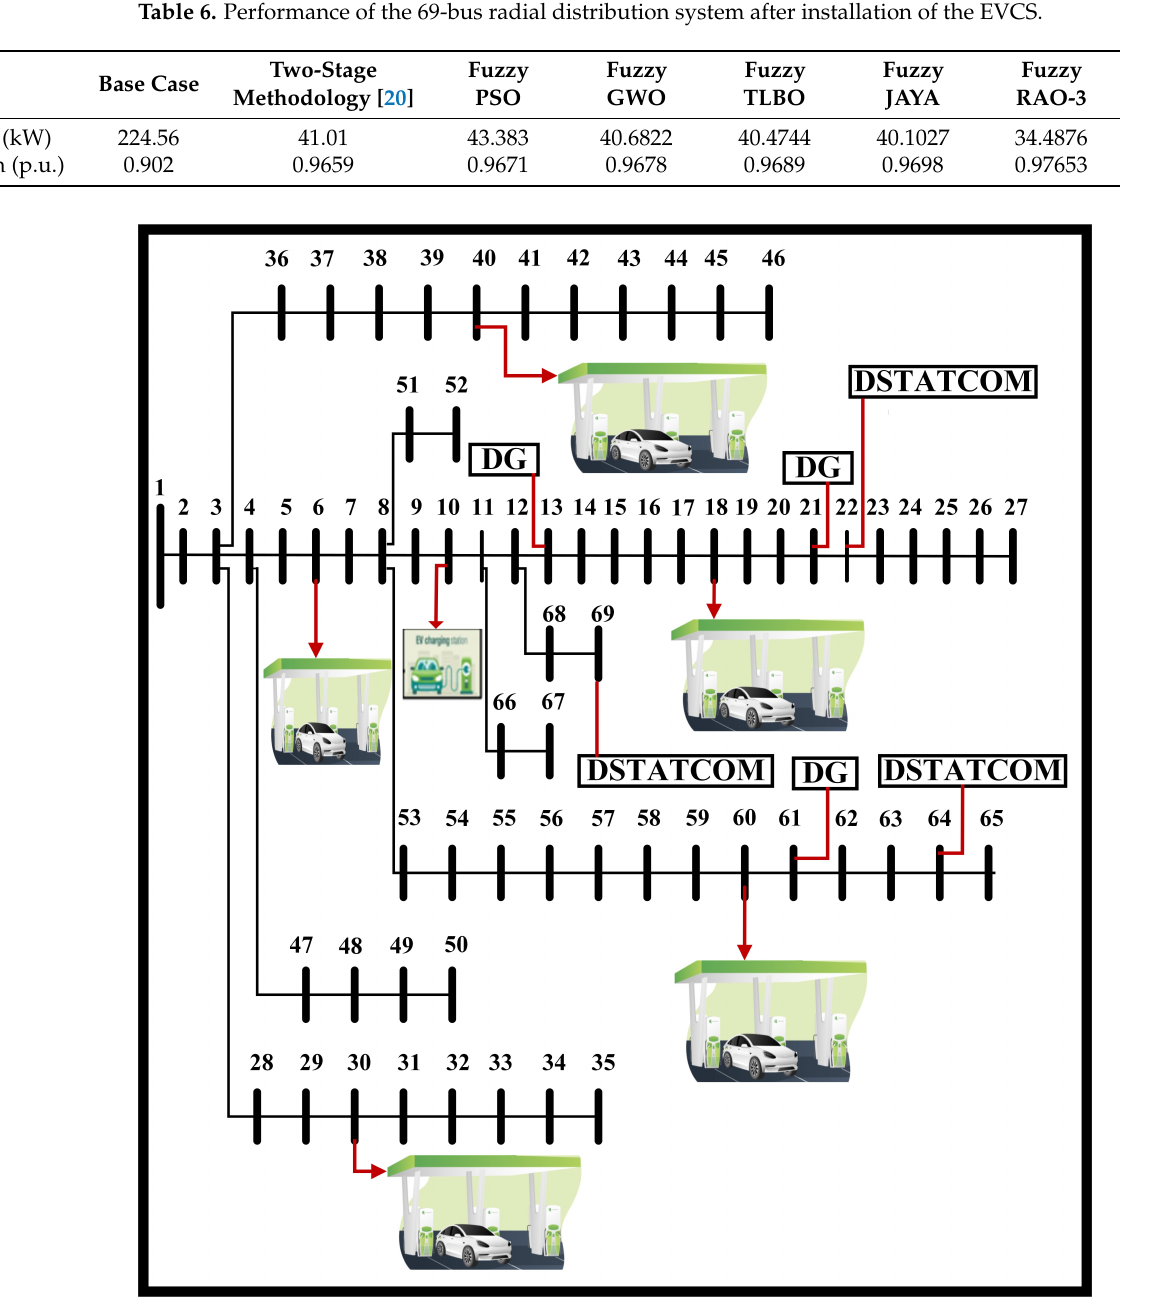
Figure 11. The single-line diagram of the 69-bus radial distribution system of scenario